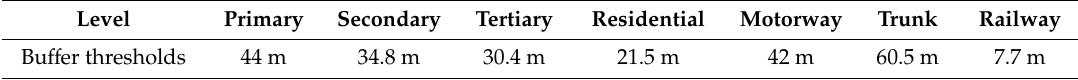
Table 1. Bu ff er thresholds for di ff erent types of roads.